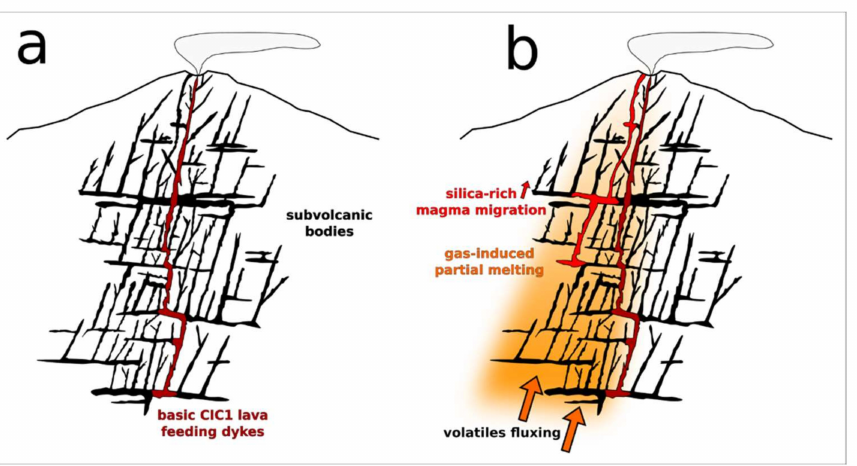
Figure 9. Schematic 2D view (not in scale) of the Etnean feeding system, constituted by crystallized subvolcanic bodies; ( a ) “classic” migration path of Etnean magmas feeding basic (CIC1) eruptions and ( b ) volatiles fluxing triggering the gas-induced partial melting producing more evolved melts (TR